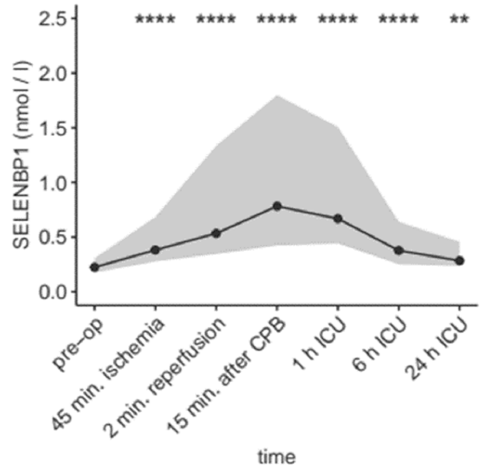
Figure 2. SELENBP1 before, during and after surgery. Median and 10 th –90 th percentile of serum SELENBP1 concentrations are provided. CPB: cardio-pulmonary bypass, ICU: intensive care unit. The values were compared to baseline by Wilcoxon's signed-rank test. **; p = 0.0072, ****; p < 0.0001.